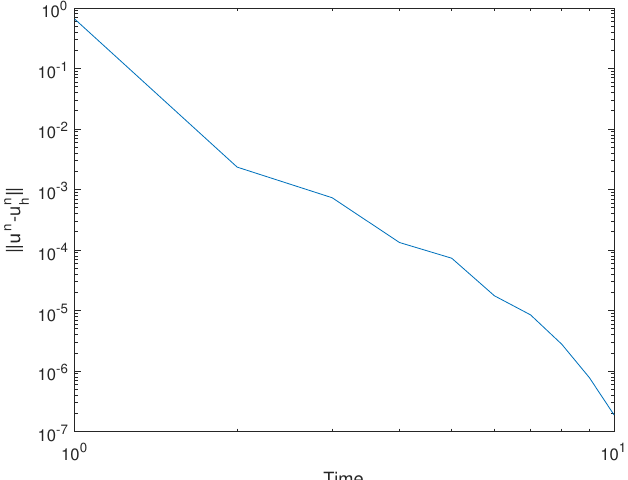
(cid:107) L 2 at mesh 40 with respect to time for Experiment 2. h